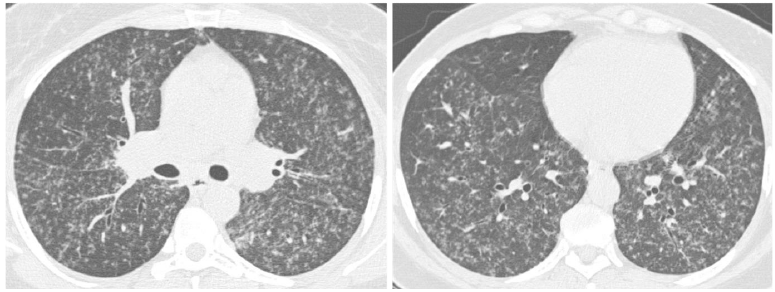
Figure 10 . Diffuse miliary nodules in an immunosuppressed patient with histoplasmosis. Axial CT images from upper and lower levels (from left to right ) depict diffuse micronodules randomly distributed in both lungs.